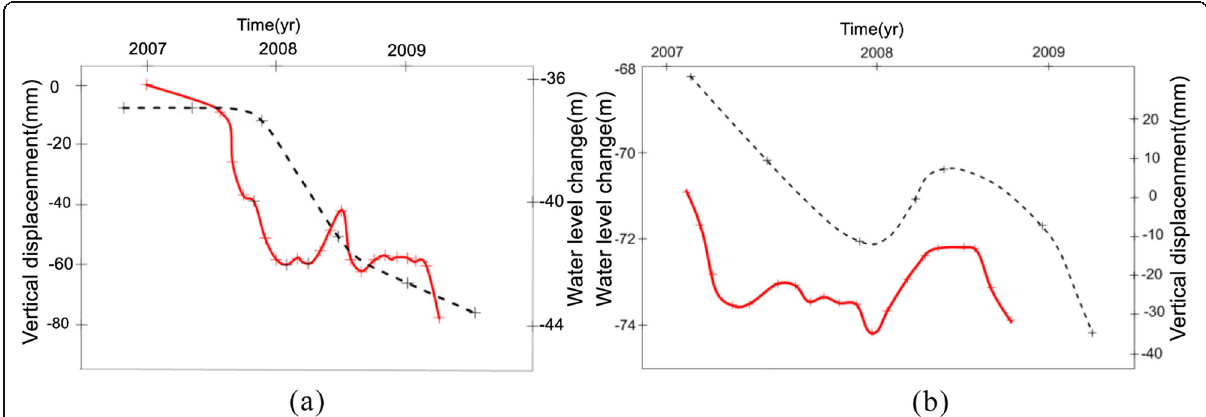
Fig. 12 A seasonal change in the water level of groundwater wells 4001 ( a ) and 1002 ( b ). The red curve represents the vertical displacement near the well sites and the black curve represents the change of the water level. Comparing Fig. 4 a and b , it was found that (1) the groundwater level in the entire region of the region has risen significantly from 2008 to 2009. This can be explained by the fact that the surface uplift in 2008 –